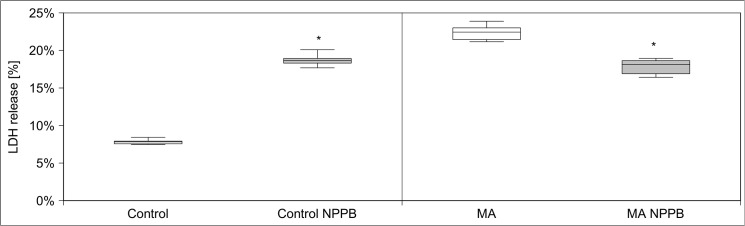
Effect of chloride channel blocker NPPB on MA mediated LDH release.The chloride channel blocker NPPB (10 µM) decreased MA induced LDH release to the corresponding control level. Data are presented as percent of untreated control of n = 6 independent experiments.